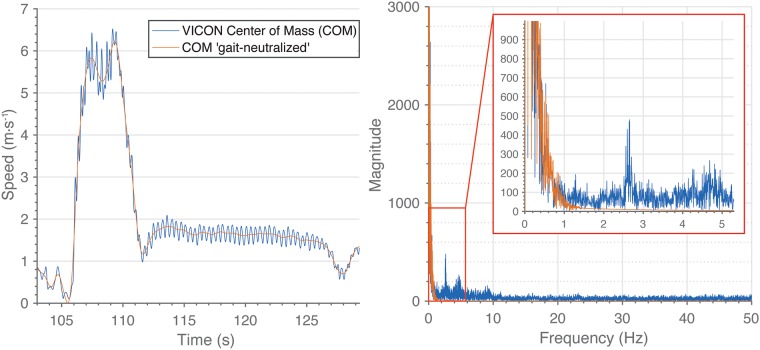
Gait-neutralization.Left: Speed signal comparison of an accelerating-cruising-walking sequence before (blue) and after (red) 2 Hz low-pass filtering (criterion measure, gait-neutralized). Right: Spectral analysis of a center of mass (COM) speed signal recorded with VICON. Blue line: unfiltered speed signal; red line: 2 Hz low-pass filtered speed signal.